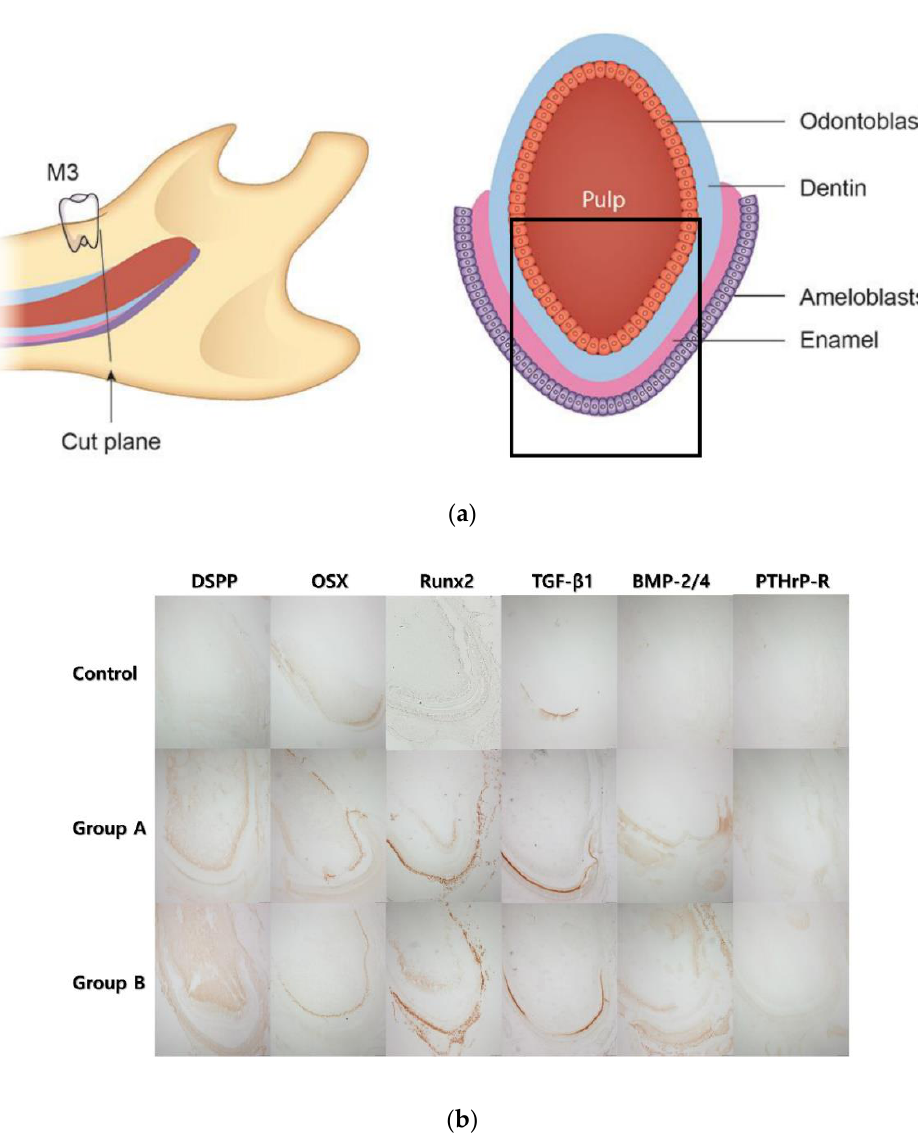
Figure 4. Results of immunohistochemistry. ( a ) Schematic drawings of the cut plane. The specimen was cut behind the third molar. The cross-section had ameloblasts and odontoblasts with pulp tissue. The boxed area in the right figure is shown in ( b ) for immunohistochemical staining. ( b ) Immunohistochemical staining for DSPP, OSX, Runx2, TGF- β 1, BMP-2 / 4, and PTHrP-R. TGF- β 1 was mainly expressed in the ameloblasts and OSX in the odontoblasts. Runx2 was expressed in both ameloblasts and odontoblasts, though more intensely in the ameloblasts. However, PTHrP-R was not highly expressed in this region.